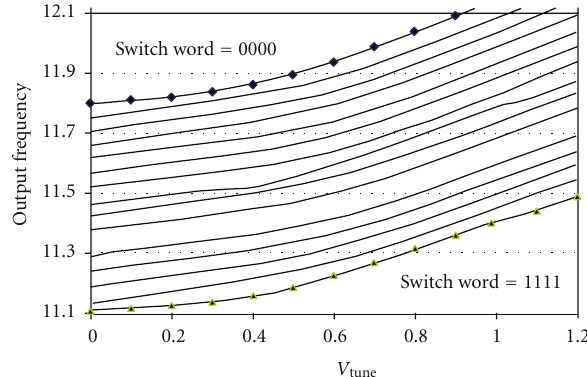
Figure 9: Frequency measurement.